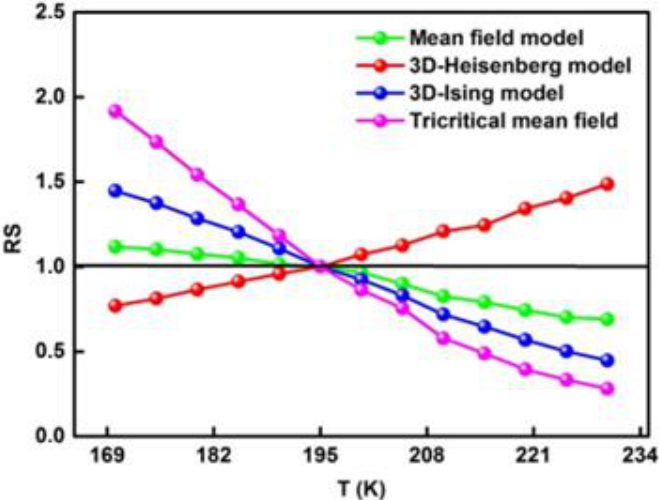
Figure 8. Relative slope (RS) as function of temperature defined as RS = S ( T ) / S ( T cr ) using different models.